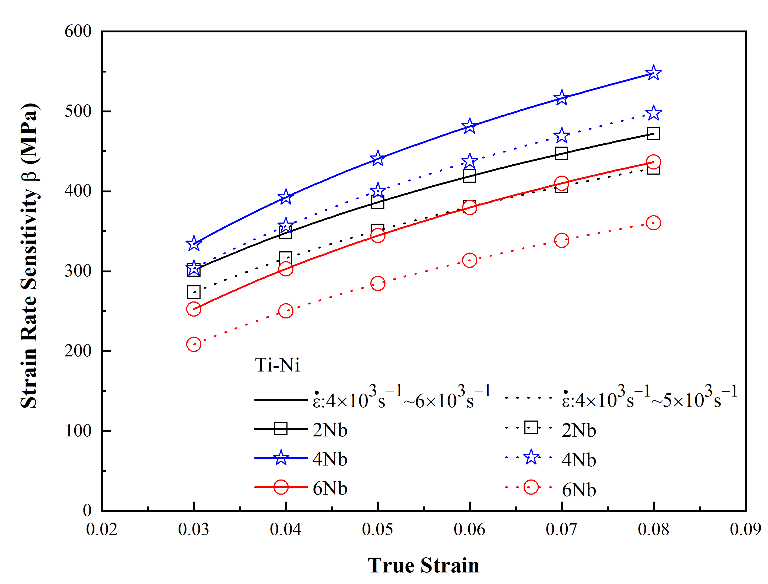
Figure 8. Strain rate sensitivity as a function of true strain under static deformation conditions.